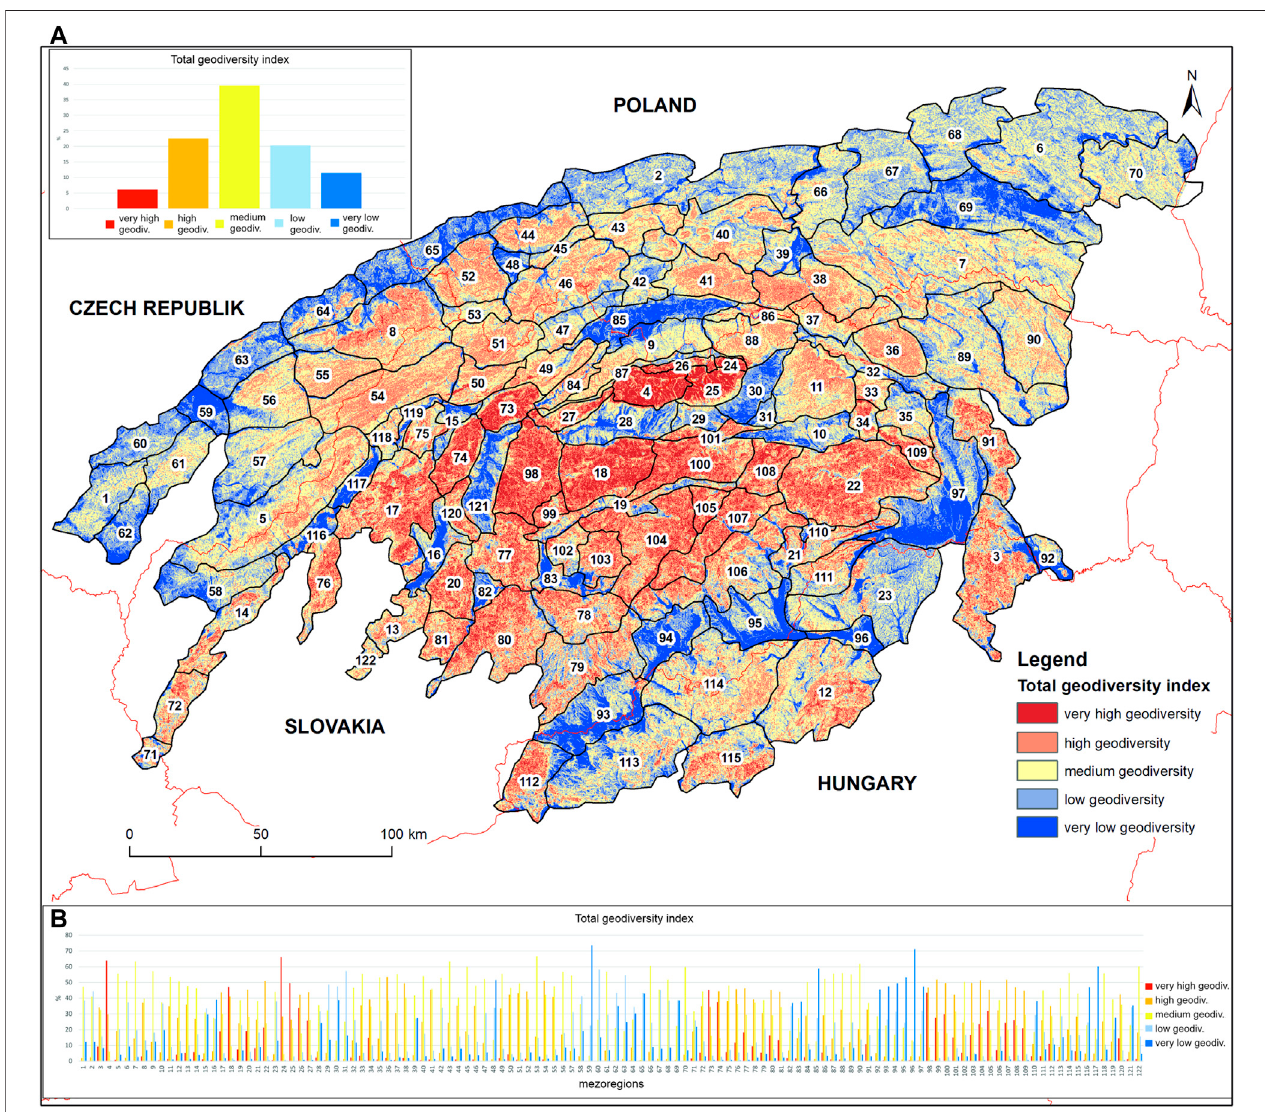
FIGURE 8 | Synthetic geodiversity map. For numbers of mesoregions, see Figure 2 . Source: own research.